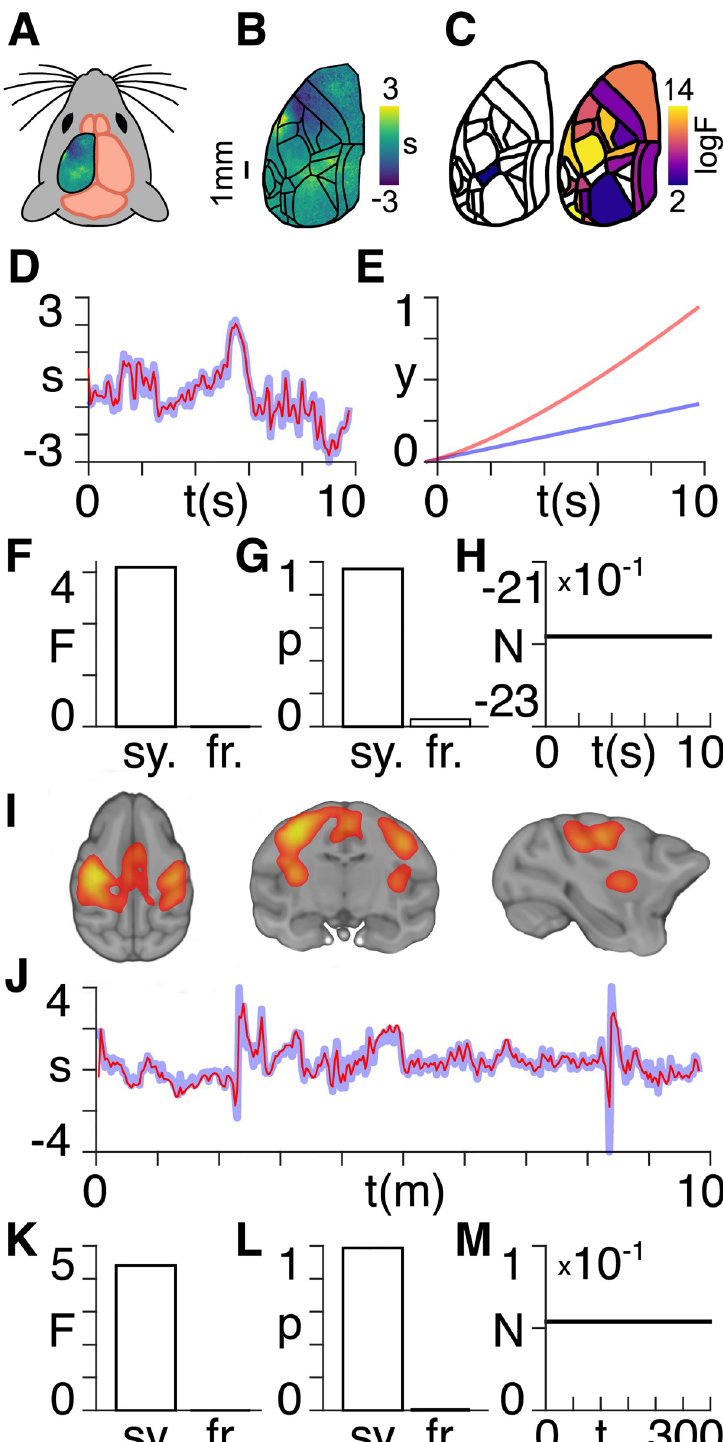
Fig 2. Neuroimaging data. A) Wide-field calcium imaging over the left hemisphere of a head-fixed mouse, expressing GCaMP6f in layer 2/3 excitatory neurons; B) Example z-scored (DF/F) activity averaged over a 10s trial length, shown as standard deviation (s) of the signal from the mean. Cortical areas are aligned to the Allen Mouse Common Coordinate Framework; C) Log variational free energy values corresponding to the colour bar, thresholded at F = 3 for regions found to have higher model evidence for scale symmetry (left) and freeness (right); D) z-scored (DF/F)